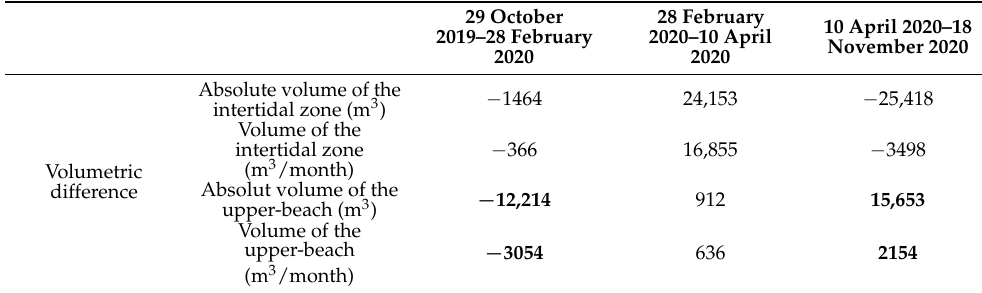
Table 4. Summary of average energetic events exceeding a water level of 5.4 m TAW related to volumetric changes. Bracket values correspond to the maximum records. Bold values indicate significant